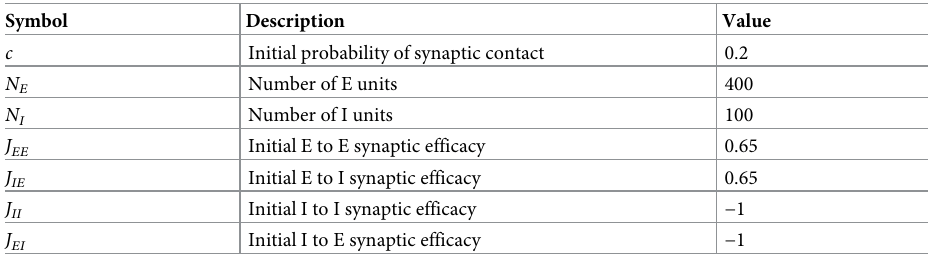
Table 1. Network